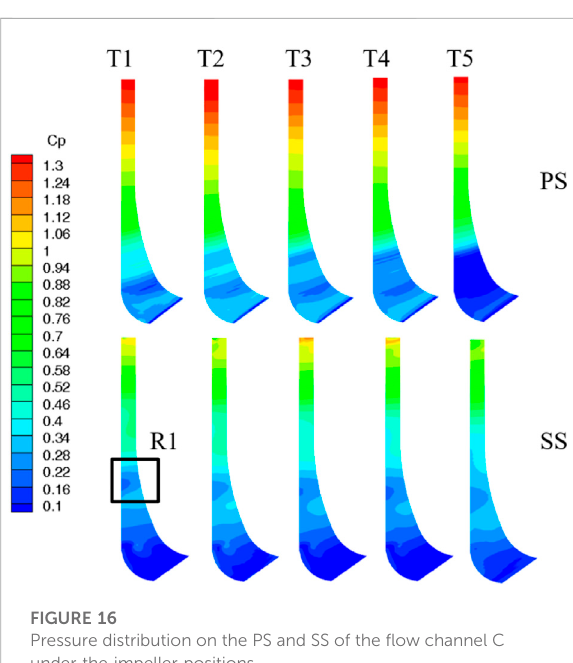
Pressure distribution on the PS and SS of the fl ow channel C under the impeller